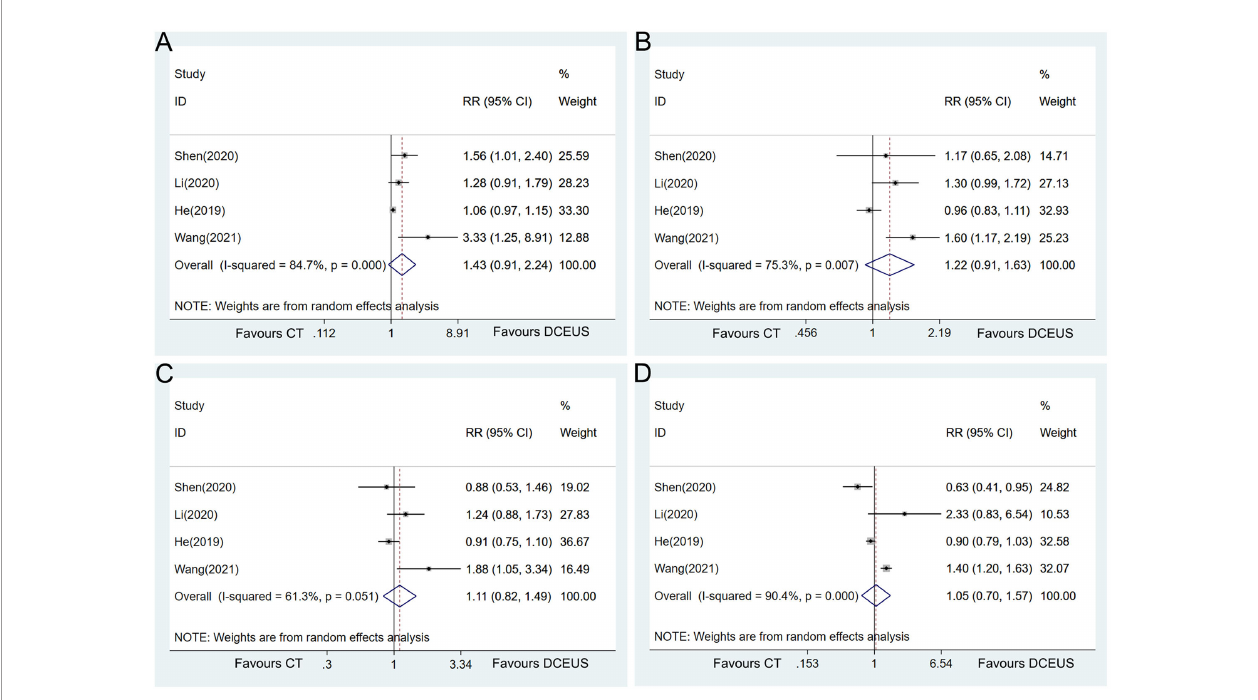
FIGURE 6 | Forest plot showing the pooled effects of diagnostic performance of double contrast-enhanced ultrasonography compared with CT in diagnosing T1 (A) , T2 (B) , T3 (C) , and T4 (D) gastric cancer.